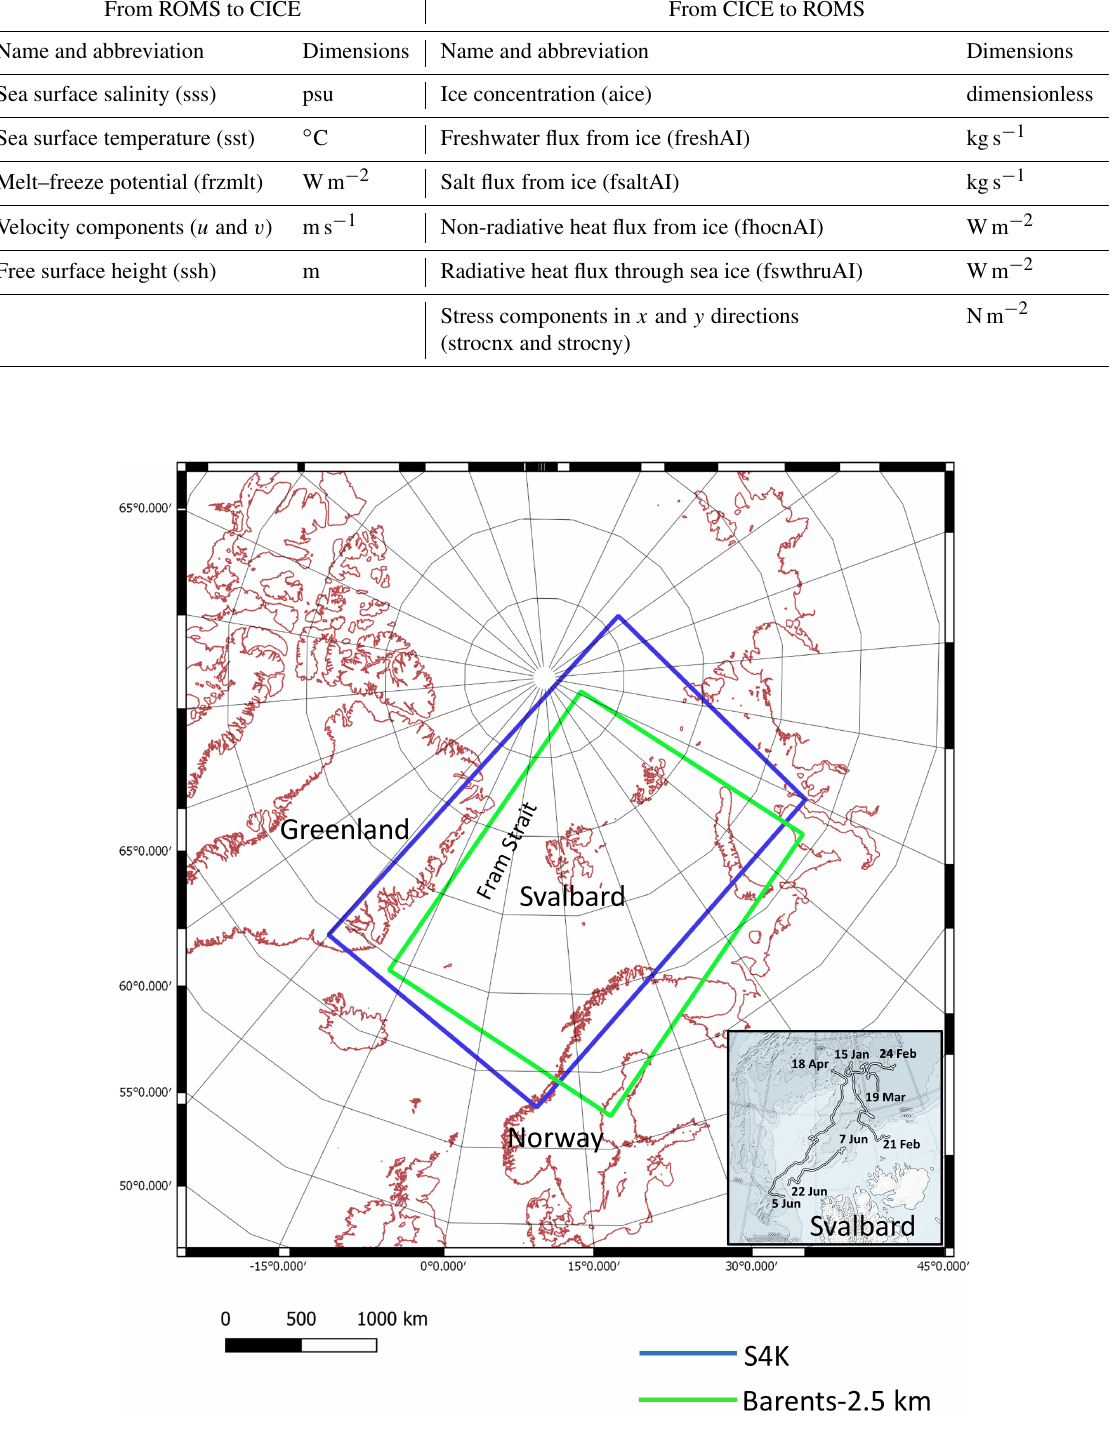
Figure 1. Barents-2.5km and S4K model domains. The insert in the bottom right corner represents Svalbard and the area where the various drifts (lines showing the start and end dates of each drift) of the N-ICE2015 expedition (Granskog et al., 2018) took place and along which sea ice and ocean data detailed in Table 5 were